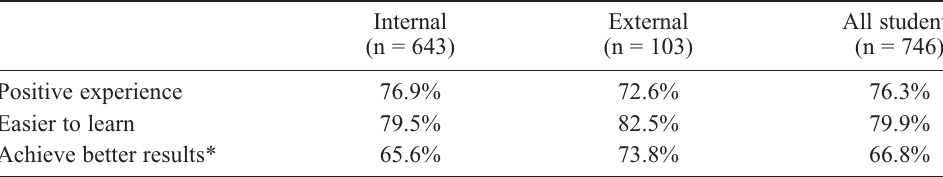
Table 2. Percentage of students’